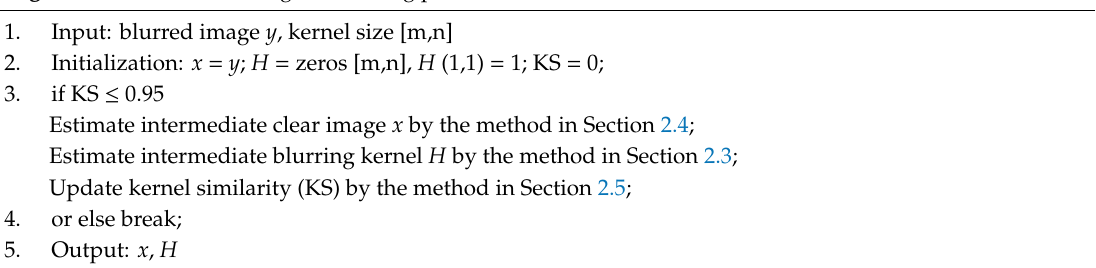
Algorithm 1. The blind image deblurring